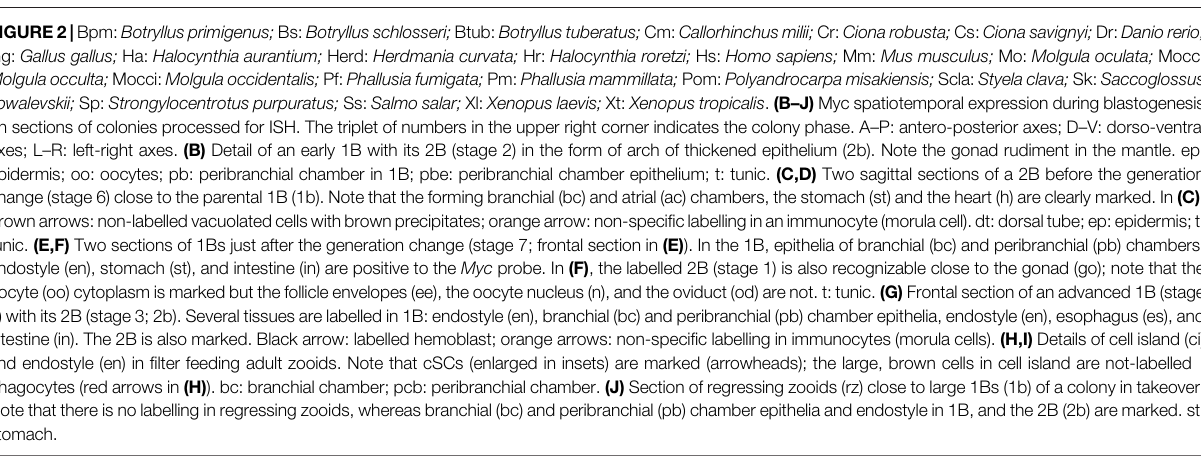
FIGURE2| Bpm: Botryllusprimigenus; Bs: Botryllusschlosseri; Btub: Botryllustuberatus; Cm: Callorhinchusmilii; Cr: Cionarobusta; Cs: Cionasavignyi; Dr: Daniorerio; Gg: Gallus gallus; Ha: Halocynthia aurantium; Herd: Herdmania curvata; Hr: Halocynthia roretzi; Hs: Homo sapiens; Mm: Mus musculus; Mo: Molgula oculata; Mocc: Molgulaocculta; Mocci: Molgulaoccidentalis; Pf: Phallusiafumigata; Pm: Phallusiamammillata; Pom: Polyandrocarpamisakiensis; Scla: Styelaclava; Sk: Saccoglossus kowalevskii; Sp: Strongylocentrotus purpuratus; Ss: Salmo salar; Xl: Xenopus laevis; Xt: Xenopus tropicalis . (B – J) Myc spatiotemporal expression during blastogenesis on sections of colonies processed for ISH. The triplet of numbers in the upper right corner indicates the colony phase. A – P: antero-posterior axes; D – V: dorso-ventral axes; L – R: left-right axes. (B) Detail of an early 1B with its 2B (stage 2) in the form of arch of thickened epithelium (2b). Note the gonad rudiment in the mantle. ep: epidermis; oo: oocytes; pb: peribranchial chamber in 1B; pbe: peribranchial chamber epithelium; t: tunic. (C,D) Two sagittal sections of a 2B before the generation change (stage 6) close to the parental 1B (1b). Note that the forming branchial (bc) and atrial (ac) chambers, the stomach (st) and the heart (h) are clearly marked. In (C) : brownarrows:non-labelledvacuolatedcellswithbrownprecipitates;orangearrow:non-speci fi clabellinginanimmunocyte(morulacell).dt:dorsaltube;ep:epidermis;t: tunic. (E,F) Two sections of 1Bs just after the generation change (stage 7; frontal section in (E) ). In the 1B, epithelia of branchial (bc) and peribranchial (pb) chambers, endostyle (en), stomach (st), and intestine (in) are positive to the Myc probe. In (F) , the labelled 2B (stage 1) is also recognizable close to the gonad (go); note that the oocyte (oo) cytoplasm is marked but thefollicle envelopes (ee), the oocyte nucleus (n), and the oviduct (od) arenot. t:tunic. (G) Frontal section ofan advanced 1B (stage 8) with its 2B (stage 3; 2b). Several tissues are labelled in 1B: endostyle (en), branchial (bc) and peribranchial (pb) chamber epithelia, endostyle (en), esophagus (es), and intestine (in). The 2B is also marked. Black arrow: labelled hemoblast; orange arrows: non-speci fi c labelling in immunocytes (morula cells). (H,I) Details of cell island